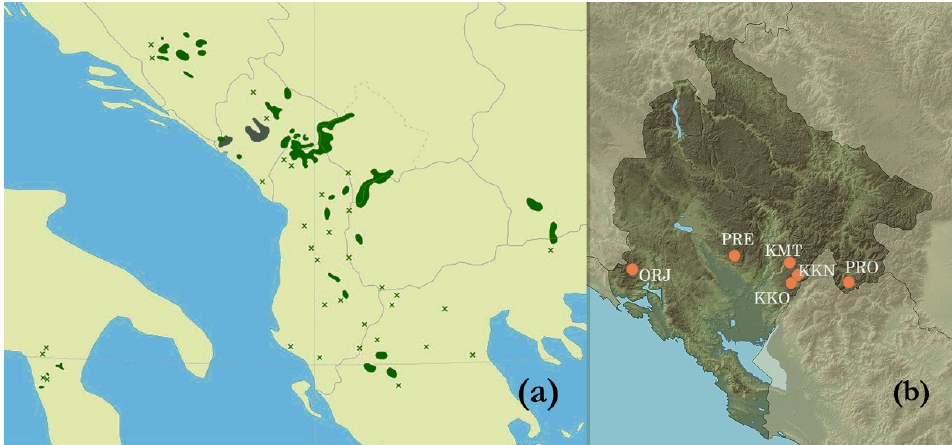
Figure 1. A map showing ( a ) distribution of Pinus heldreichii in the Mediterranean region; a grey area was added and represents an additional P. heldreichii site; the map is adapted from [18] and ( b ) sampling sites in Montenegro (ORJ-Orjen; PRE-Prekornica; KKO-Ku č i Mt, Ku č ka korita; KKN-Ku č i Mt., Ku č ka korita North, KMT- Ku č i mountain, Momonjevo, PRO- Prokletije); a map was adapted from [19]. Table 1. Characteristics of Pinus heldreichii sampling sites.